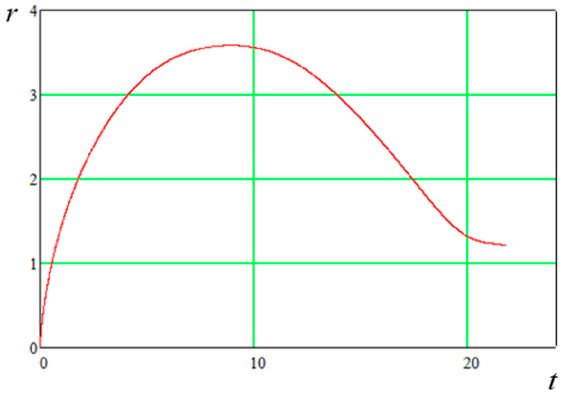
Figure 4. Geocentric distance of the SC [undim.] along the flight trajectory as a function of flight time [undim.].